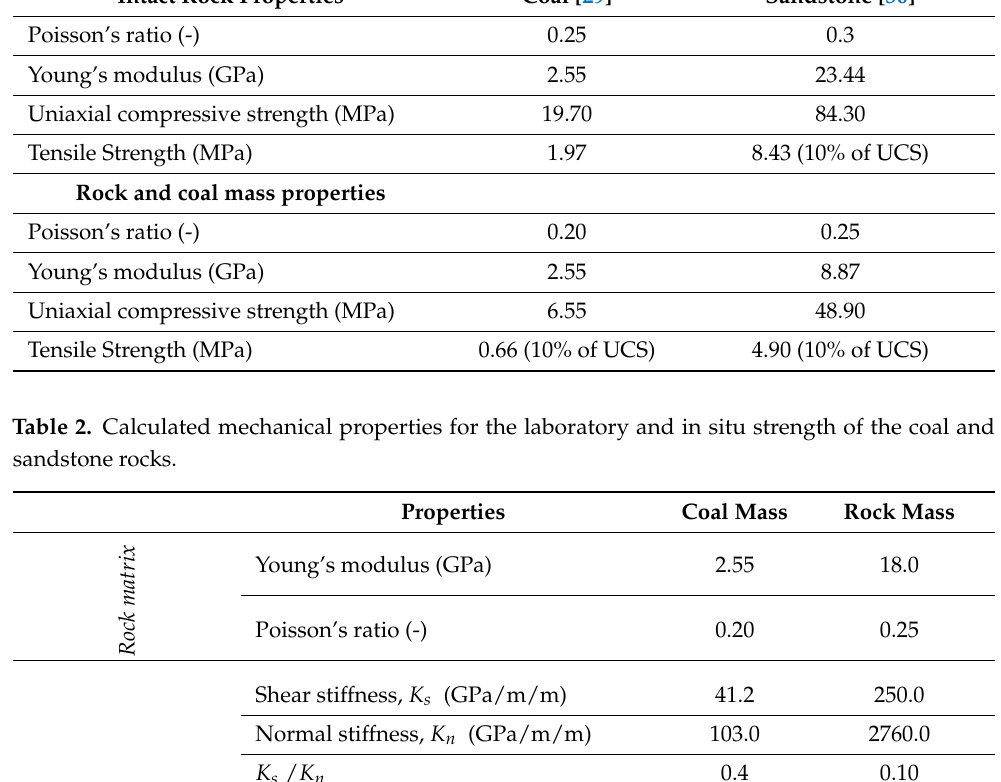
Table 1. Simulation parameters for coal and rock specimens.